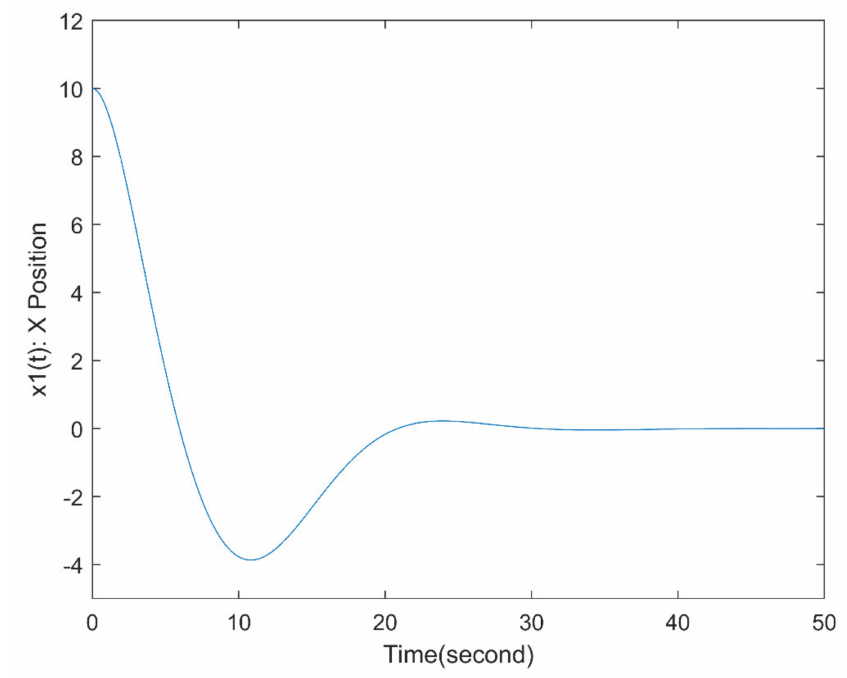
Figure 2. Response of state x 1 ( t ) .